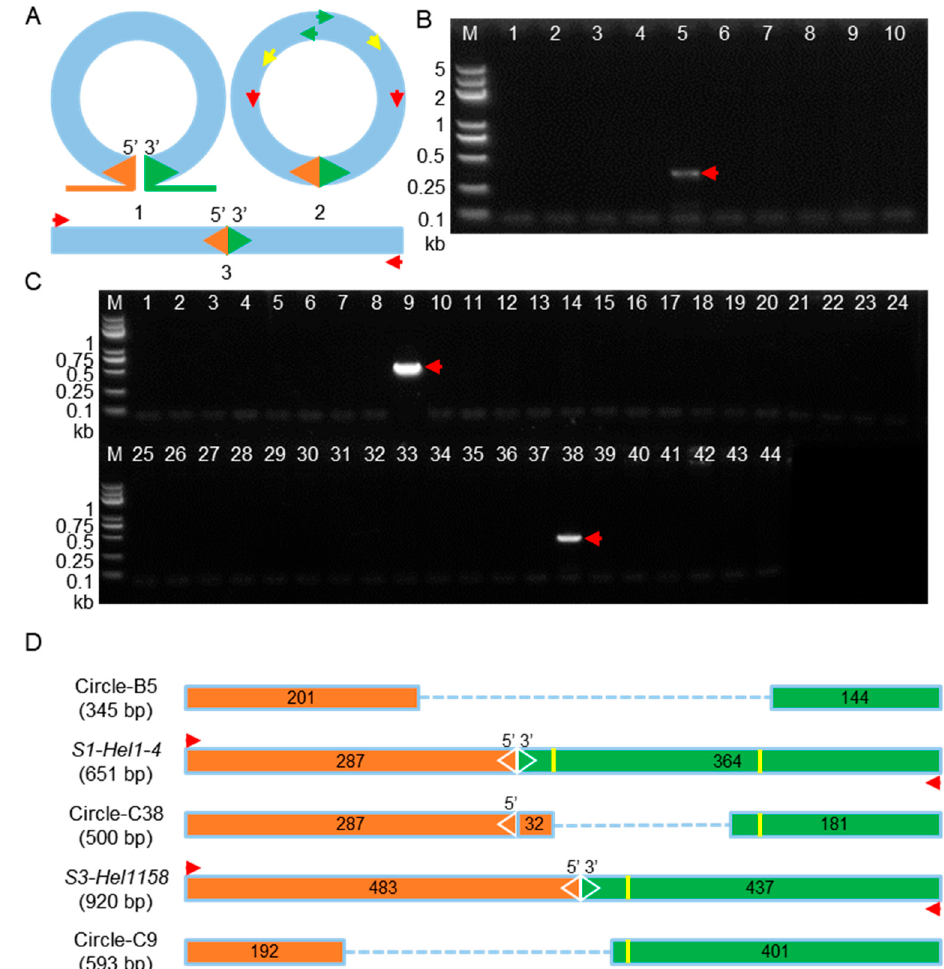
Figure 7. Schematic representation and PCR detection of circular dHel intermediates from leaf tissues of transgenic plants transformed with c1-dHel-GFP constructs. ( A ) Schematic diagram of circular dHel-GFP (1) and nested-PCR primer combinations (pairs of color-coded arrows in 2) to amplify somatic circular dHel intermediates (3); ( B ) Lanes 1–10, T 2 transgenic lines from S1-Hel1-4 construct; ( C ) F 1 segregants from a test-cross between different c1-dHel-GFP T 2 transgenic plants and the c1 tester line. Lanes 1–6, S3-Hel1613; lanes 7–11, S3-Hel1158; lanes 12–18, S3-HelA2; lanes 19–23, S4-Hel1-4; lanes 24–28, S2-Hel1-4; lanes 29–34, S3-Hel1-4; lanes 35–41, S1-Hel1-4; Lanes 42–44, F 1 individuals from a cross between a non-transgenic line and the c1 tester. Red arrows, PCR products of putative circular dHel intermediates; ( D ) Schematic representation of sequence features of circular intermediates from ( B ) and ( C ) (red arrows). The expected circular dHel intermediates (A3) are inverse PCR amplification of a fused 5 (cid:48) -end upstream sequence with 3 (cid:48) -end downstream sequence color-coded as orange and green, respectively. Red arrows are PCR primers, light blue dotted lines are internal deletions, vertical yellow bars are palindromic sequences upstream of the 3 (cid:48) -end CTAG, and the sequence configurations are labeled with numbers in the color-coded